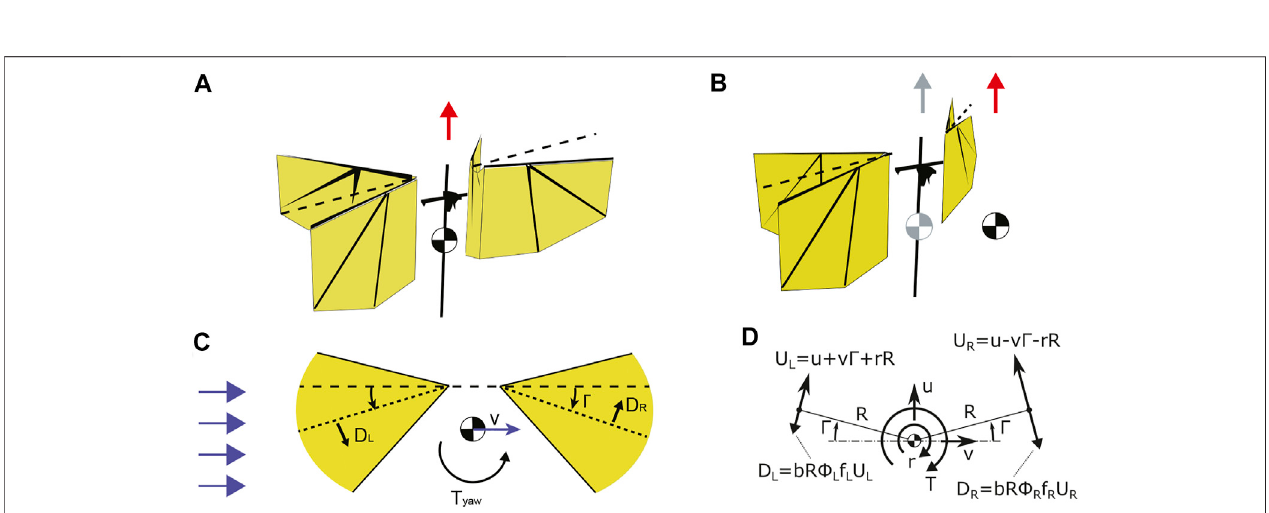
FIGURE2 | Wing actuation and aerodynamic forces and torques during the roll, pitch, and yaw control. Magenta arrows show actuation action, gray arrows show the nominal wingbeat-average aerodynamic thrust vectors, and red arrows show wingbeat-average thrust and torques after control actuation (adapted from Karásek et al.